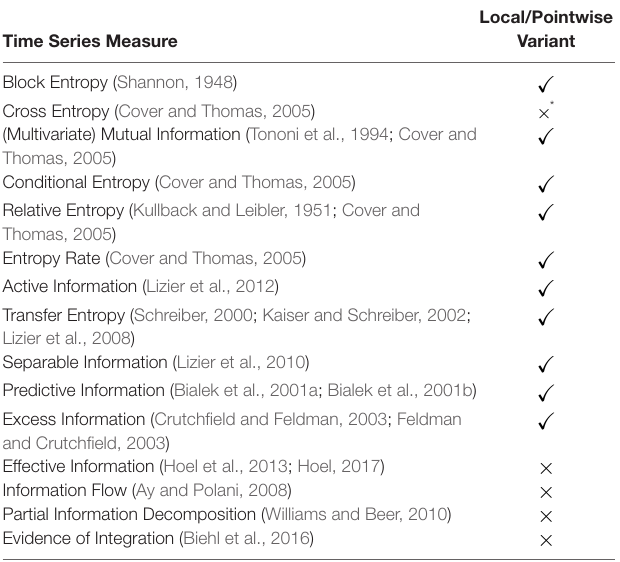
TABle 1 | The time series measures available in inform